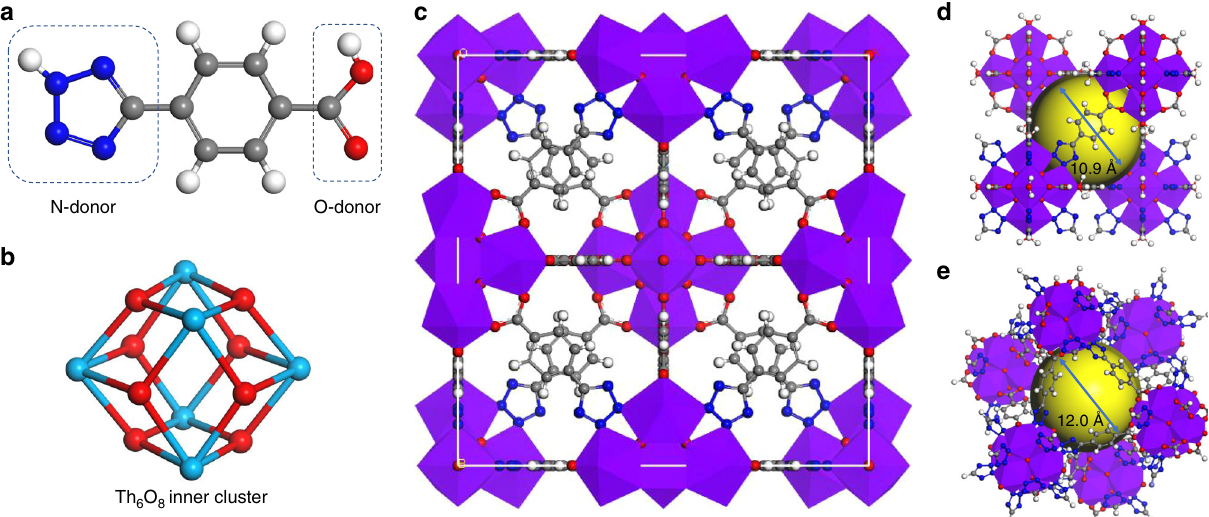
Fig. 1 Main structures. a Ligand TBA, including carboxylic acid donor (O-donor) and tetrazole donor (N-donor), b inner core Th 6 -cluster drawn alone for clarity (Th 6 O 8 ), c unit cell structure in crystal Azole-Th-1, d , e two types of cages, including super tetrahedron cage d and super octahedron cage e . Where, Th-light blue ball b and polyhedron style c – e with purple color, O-red ball, C-gray ball, N-blue ball, and H-white